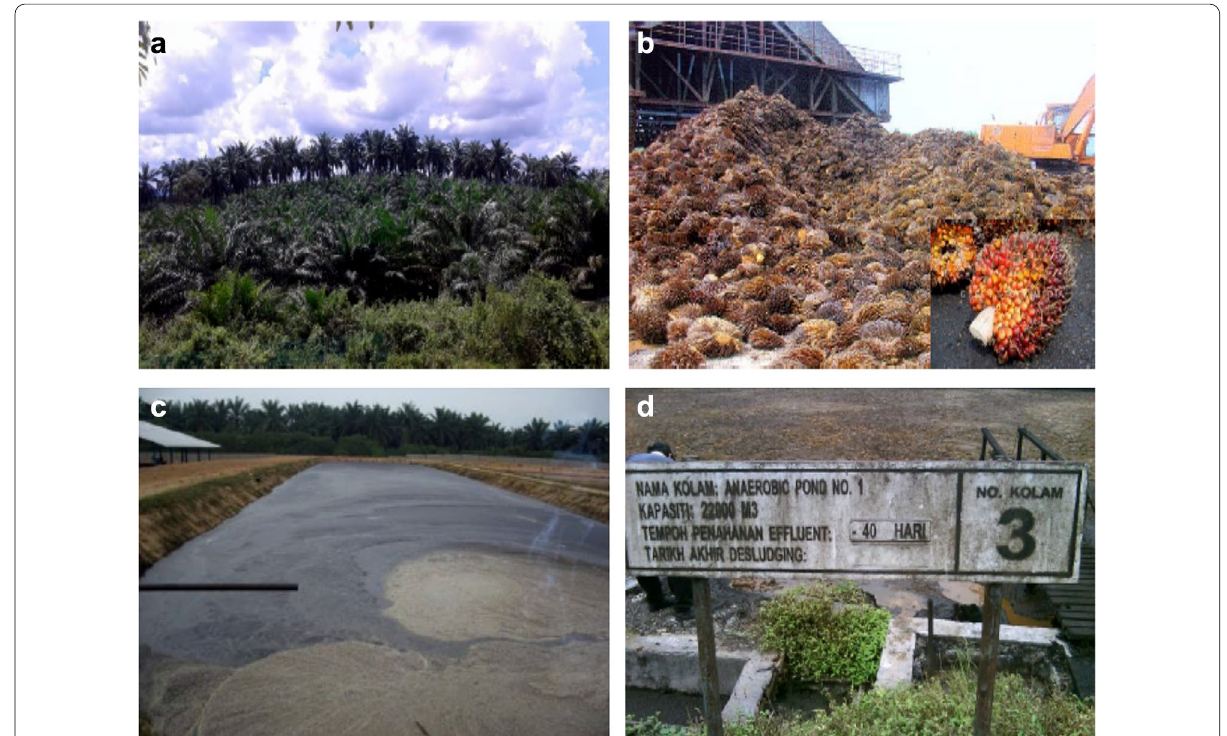
Fig. 1 Biomass and effluent generated by the palm oil industry: a oil palm plantation, b FFBs, c open pond, d anaerobic treatment